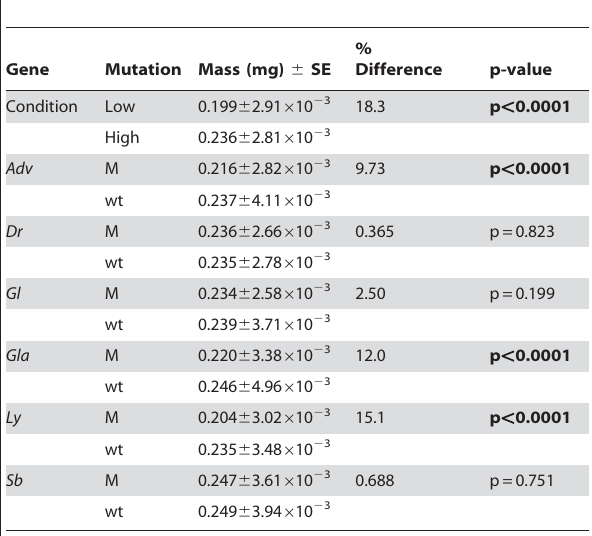
Table 1. Effects of condition and mutations on body mass (mean + / 2